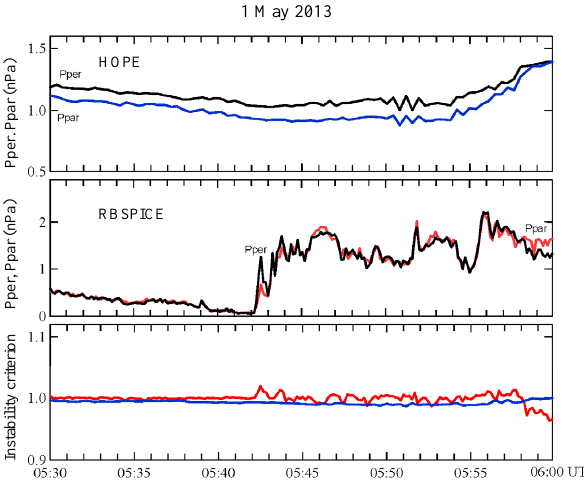
Figure 7. Plasma parameters from both HOPE (energies from 1eV to 50keV) and RBSPICE (energies from 20keV to 1MeV) instru- ments to cover the full range of proton energies from 05:30 to 06:00UT. From top to bottom, the panels show the perpendicular (Pper) and parallel (Ppar) pressures (ECT) from the HOPE and the RBSPICE instruments and results from tests of the mirror instabil- ity criterion. The blue curve marks the result for the HOPE data, while the red one marks the results for RBSPICE data.